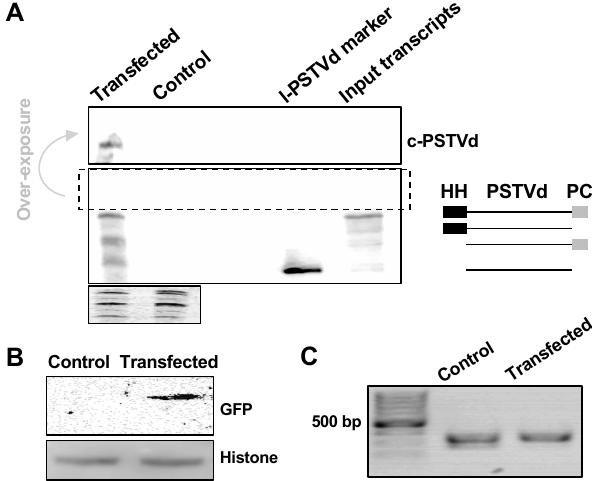
Figure 5. Co-purification of DNA, RNA, and proteins from protoplasts. PSTVd and 35S:: GFP co-transfected Arabidopsis protoplasts were harvested two days post-transfection. DNA, RNA, and proteins were co-purified using our new method. ( A ) RNA gel blotting detected the replication of PSTVd in Arabidopsis protoplasts, and the ethidium bromide staining of ribosomal RNAs served as a loading control. We used two size markers as shown in two right lanes on the blot: The unit-length linear PSTVd (l-PSTVd) RNA and the RZ-Int (input transcripts) RNA. The RZ-Int RNA contains a full-length RNA with a hammerhead ribozyme, an l-PSTVd, and a paperclip ribozyme arranged from the 5’ to 3’ end. The ribozyme activities result in four RNA species. The size illustration for the mixture of the RZ-Int inoculum is on the right panel. HH and PC represent the hammerhead and paperclip ribozymes, respectively. ( B ) Immunoblotting detected the expression of GFP, wherein histone H3 served as a loading control. ( C ) PCR using purified genomic DNA amplified a fragment from endogenous TFIIIA gene. c-PSTVd refers to the circular PSTVd genome.